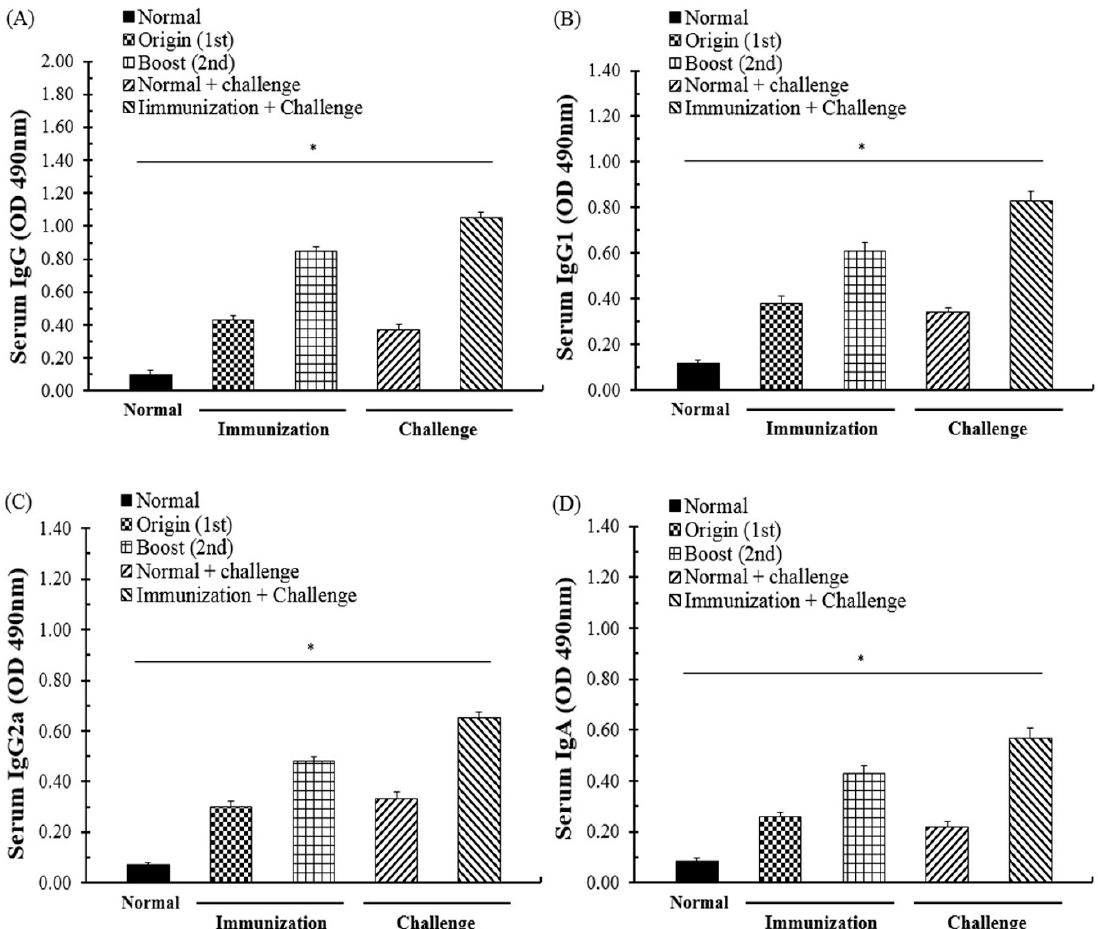
Figure 5. T. gondii antibody response after immunization and T. gondii infection. The sera of mice were collected at 4 weeks after the first and second immunization, and at 1 week after T. gondii infection, respectively. ( A ) IgG, ( B ) IgG1, ( C ) IgG2a, and ( D ) IgA antibody responses were evaluated using the sera at the time point, respectively. The groups were divided as follows: (1) the immunization step: the normal group and immunization group (the group immunized with SAG1-VLP), and (2) the parasite infection step: the normal group, normal (non-immunized) group infected with T. gondii , and T. gondii infection group immunized with